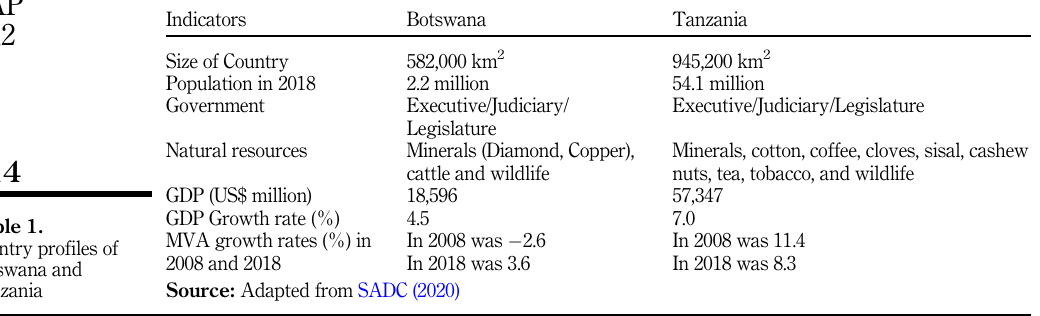
Table 1. Country profiles of Botswana and Tanzania